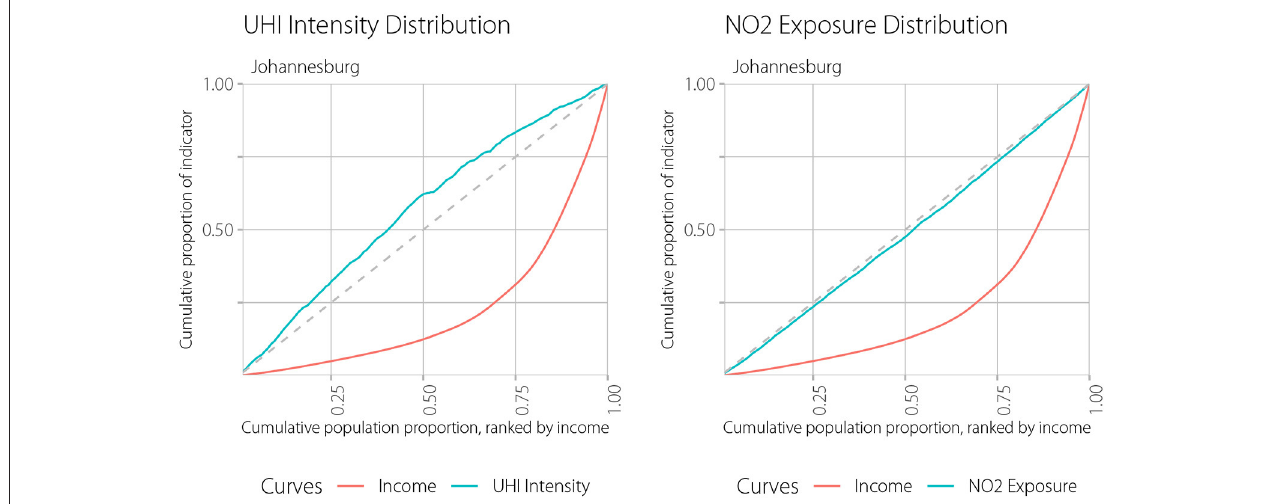
FIGURE 2 | Example of the distribution of the Lorenz Curve (Red), measuring income, and the UHI Intensity and NO 2 Exposure Concentration Curves (Blue) for the city of Johannesburg. The UHI Exposure Concentration Curve’s position above the 45 ◦ line of perfect equity indicates that UHI Intensity is concentrated in the low-income populations in the city. By contrast, the NO 2 Concentration Curve suggests that NO 2 exposure is only slightly more concentrated in high-income populations, since it is still within a marginal distance from the line of perfect equity. The Lorenz Curve indicates that there is an important inequality in the distribution of income, due to the distance of the curve from the 45 ◦ line of perfect